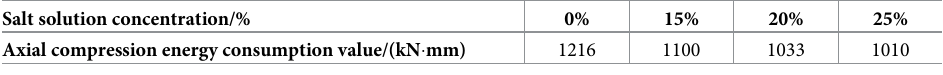
Table 9. Total axial energy consumption of unreinforced specimens with different concentrations of salt